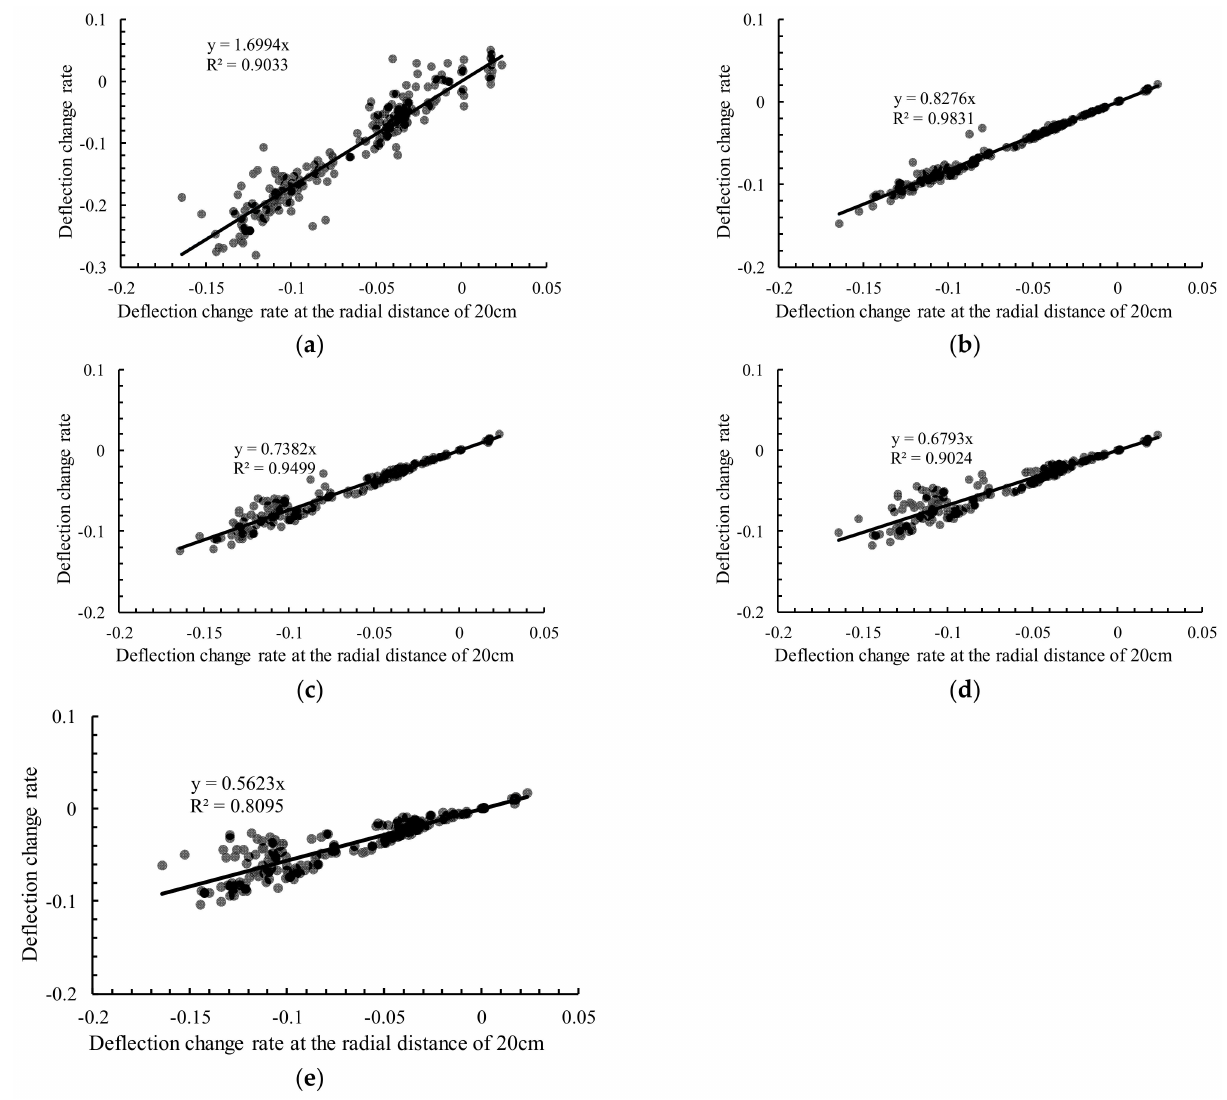
Figure 11. Deflection change ratio at each radial distance to the deflection change rate at 20 cm: ( a ) 20 cm; ( b ) 30 cm; ( c ) 45 cm; ( d ) 60 cm; ( e ) 90